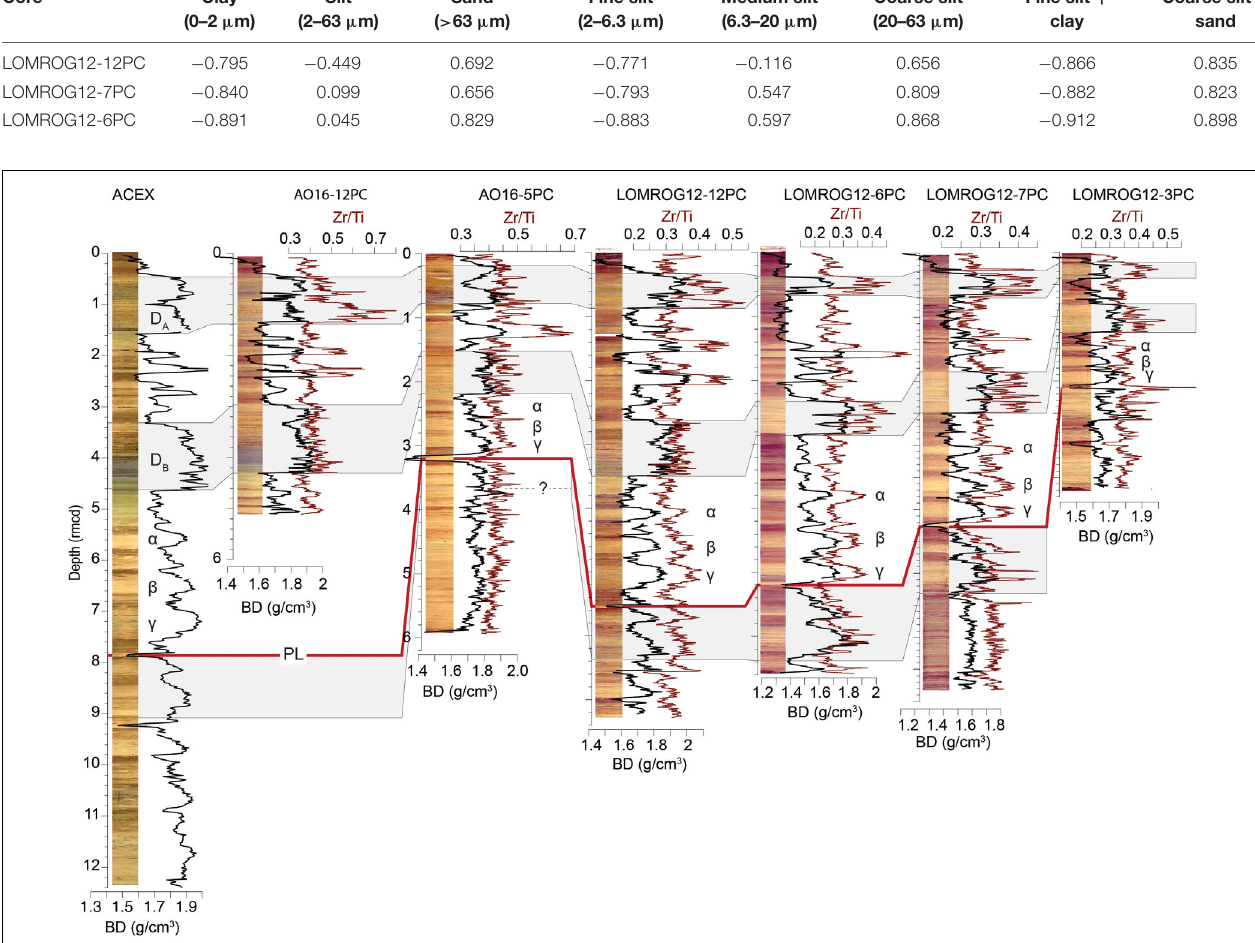
FIGURE 5 | Stratigraphic correlation of multiple records across ∼ 575 km of the Lomonosov Ridge (see Figure 3 for core locations). Correlations are shown using the bulk density and Zr/Ti proxies for grain size. They are further supported by downcore changes in sediment color (images) as well as K/Ti and Mn/Ti profiles ( Supplementary Information ). The bold red correlative line indicates the position of a distinct fine-grained (95–100% clay) peach colored layer (labeled PL). Greek symbols ( α , β , γ ) highlight a correlative sequence of grain size and color variations that are recognized above the fine-grained peach colored layer (PL). The two diamicts found near the top of all the cores are labeled D B and D A